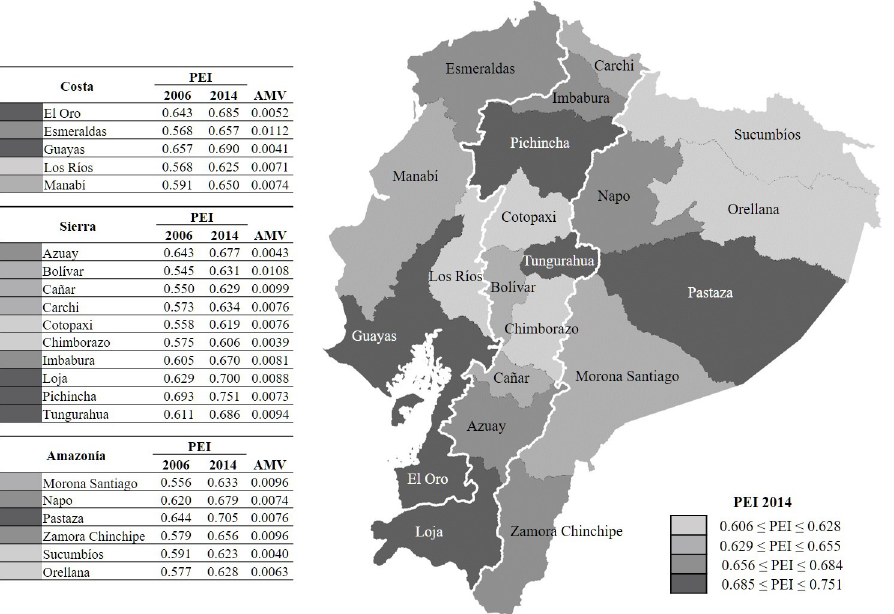
Fig 1. Provincial-level Education Index by quartiles in 2014 and annual mean variation. 2006 and 2014. Notes: the Galapagos region was removed since it was not subject to analysis; the provinces of Santo Domingo and Santa Elena are included in Pichincha and Guayas, respectively; approximate results for the provinces of Amazonia in 2006 due to lack of representativeness in the survey. PEI = Provincial-level education index; AMV = annual mean variation; AMV = (PEI(2014)–PEI(2006))/(2014–2006).